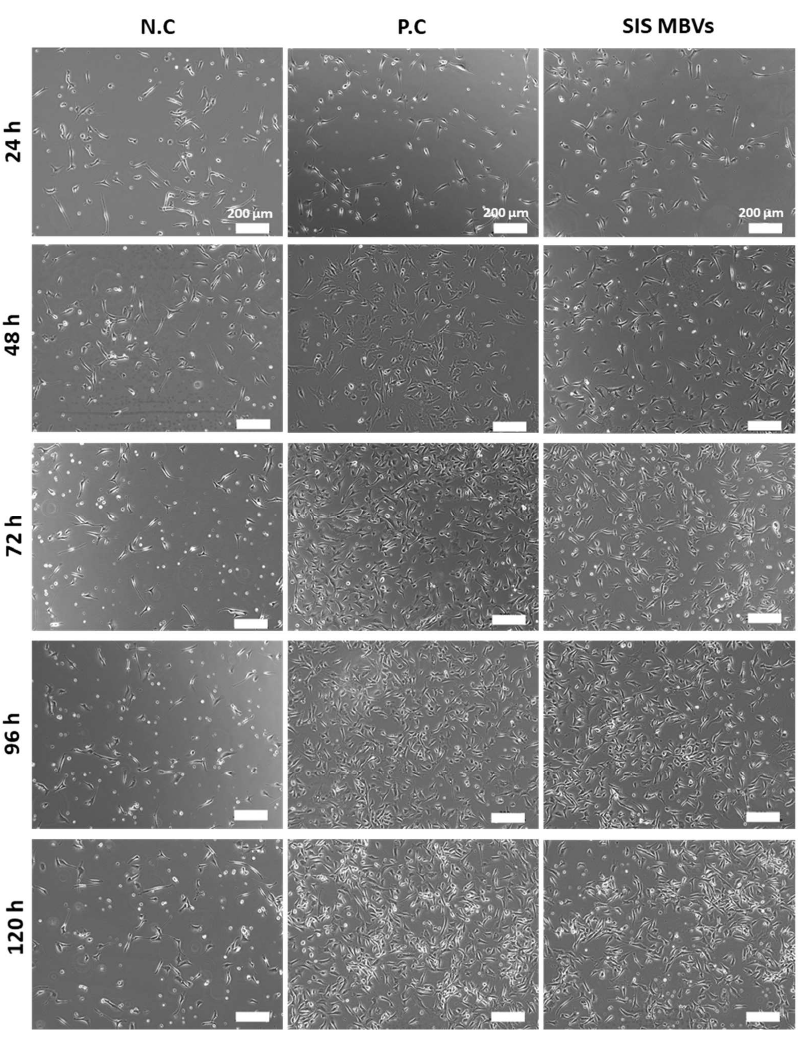
Figure 7. Morphology of HH cells exposed to MBVs derived from HHP-decellularized SIS. Scale bar: 200 µm.